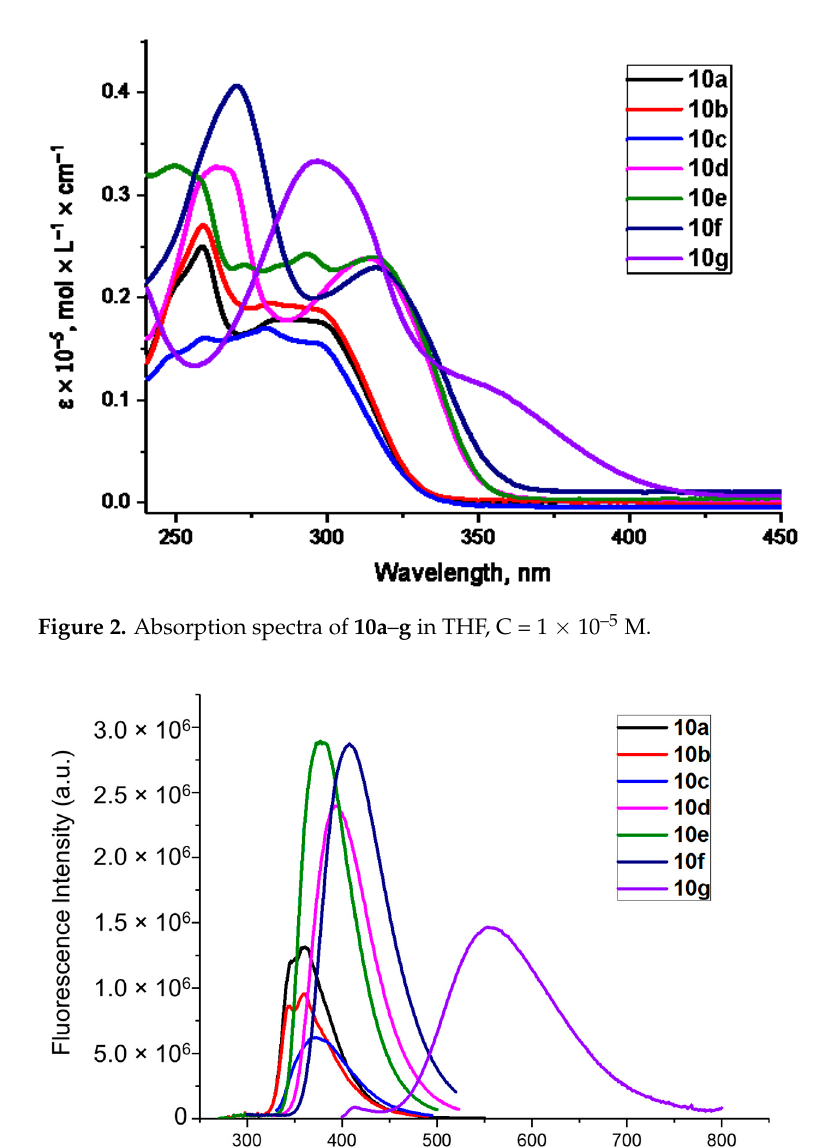
Figure 3. Emission spectra of 10a – g in THF, C = 1 × 10 − 6 M.